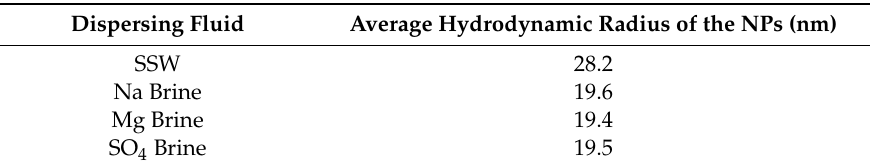
Table 4. Particle size of the dispersed silica